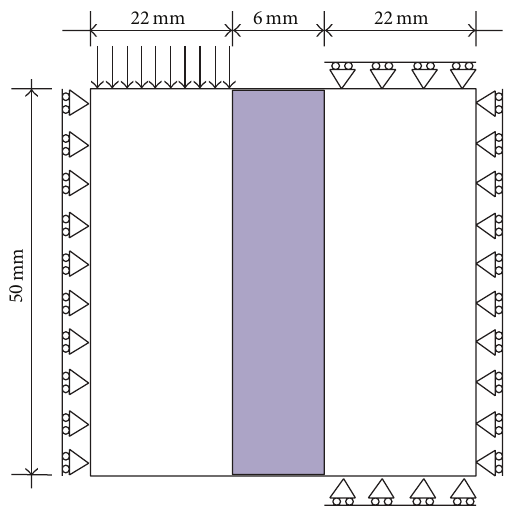
Figure 3: Considered shear loaded plate in plane strain.